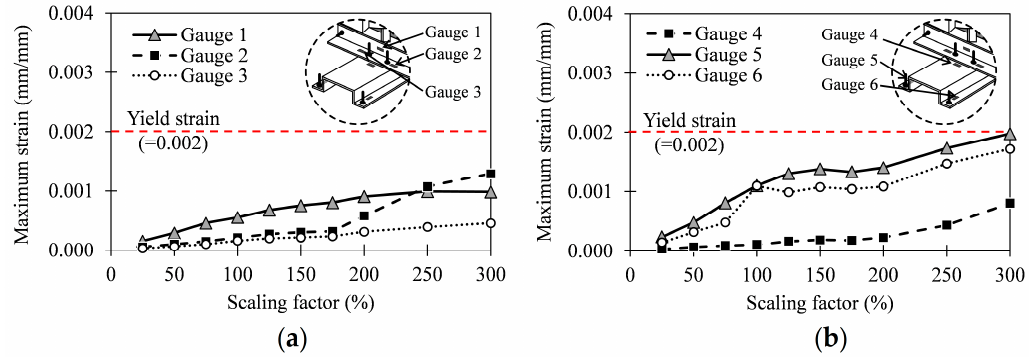
Figure 18. Maximum strain of the bottom and bed beams of test specimen according to scaling factor. ( a ) At the bottom beam; ( b ) At the bed beam.